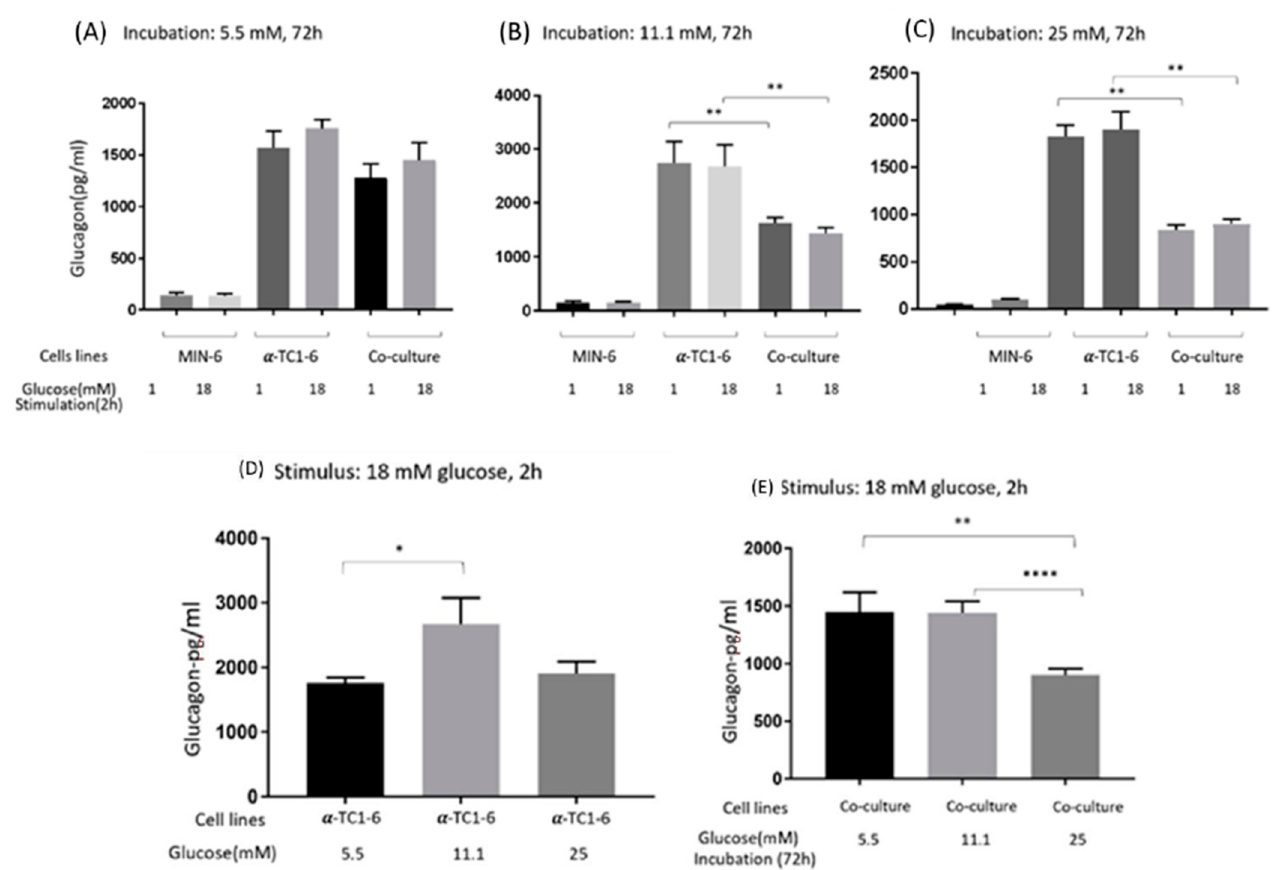
Figure 2. Glucagon secretion from mono- or co-cultured MIN-6 and α -TC1-6 cells when stimulated with low (1mM) or high (18 mM) glucose after 72 h incubation in ( A ) 5.5, ( B ) 11.1, or ( C ) 25 mM. ( D ) Glucagon secretion from α -TC1-6 cells when stimulated with high glucose after 72 h incubation in 5.5 mM, 11.1, or 25 mM glucose. ( E ) Glucagon secretion from co-cultured cells when stimulated with high (18 mM) glucose after 72h incubation in 5.5, 11.1, or 25 mM glucose. Data are presented as the mean ± SEM of 18 samples per condition from three independent experiments. * p < 0.05, ** p < 0.01, **** p < 0.0001.